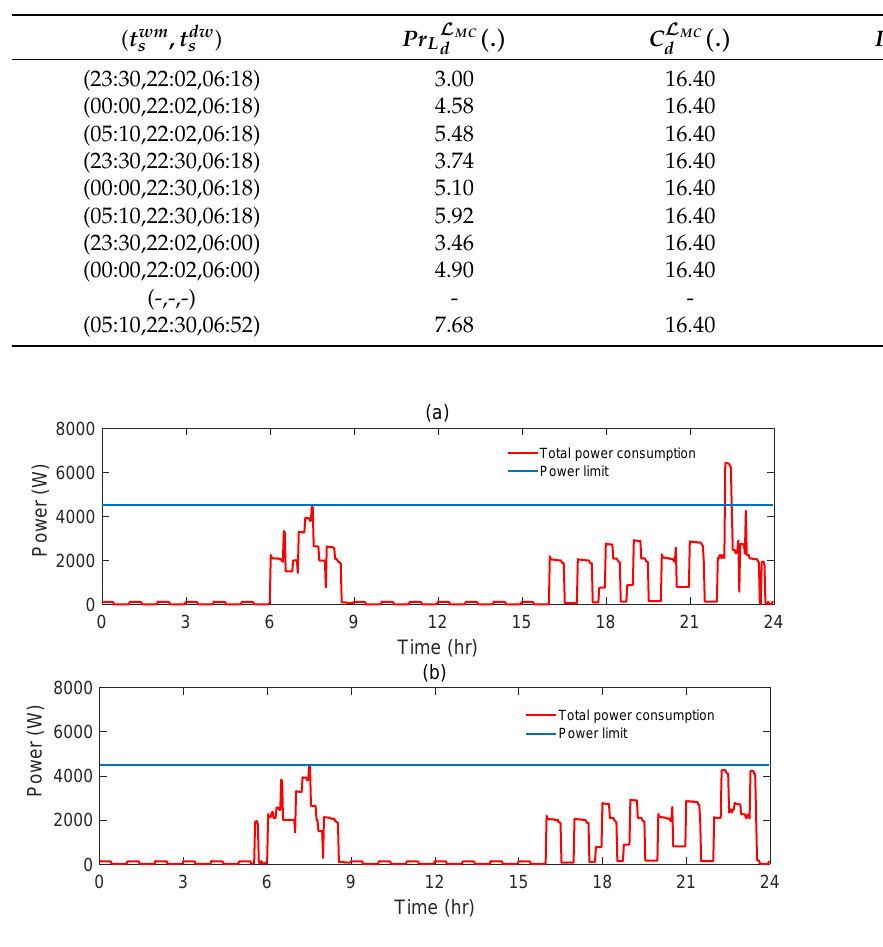
Figure 11. Power consumption graph of minimum cost ( a ) and optimal ( b ) solution for Scenario